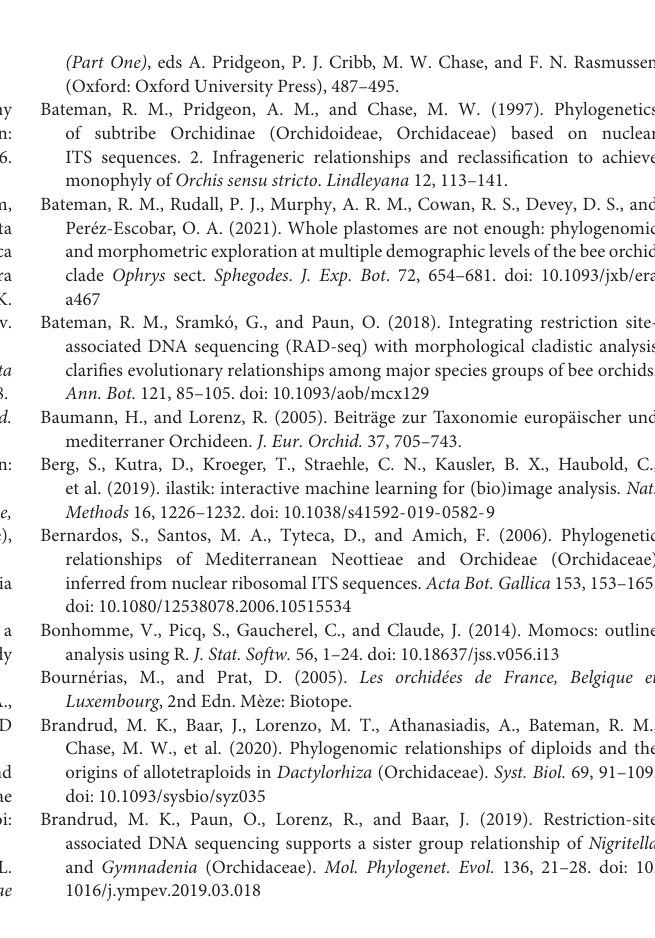
Supplementary Figure 2 | Meiotic and mitotic chromosome spreads of selected individuals of Neotinea. Supplementary Figure 3 | NeighbourNet based on 3,090 random SNPs. Supplementary Figure 4 | PCA biplot of data subset including (A) individuals of N. lactea group and (B) N. ustulata. Supplementary Figure 5 | PCA biplot of data subset of all subgroups of N. tridentata. Supplementary Table 1 | Overview of the populations used in the study supplemented with flow cytometry results. Supplementary Table 2 | Overview of morphological characters used for multidimensional